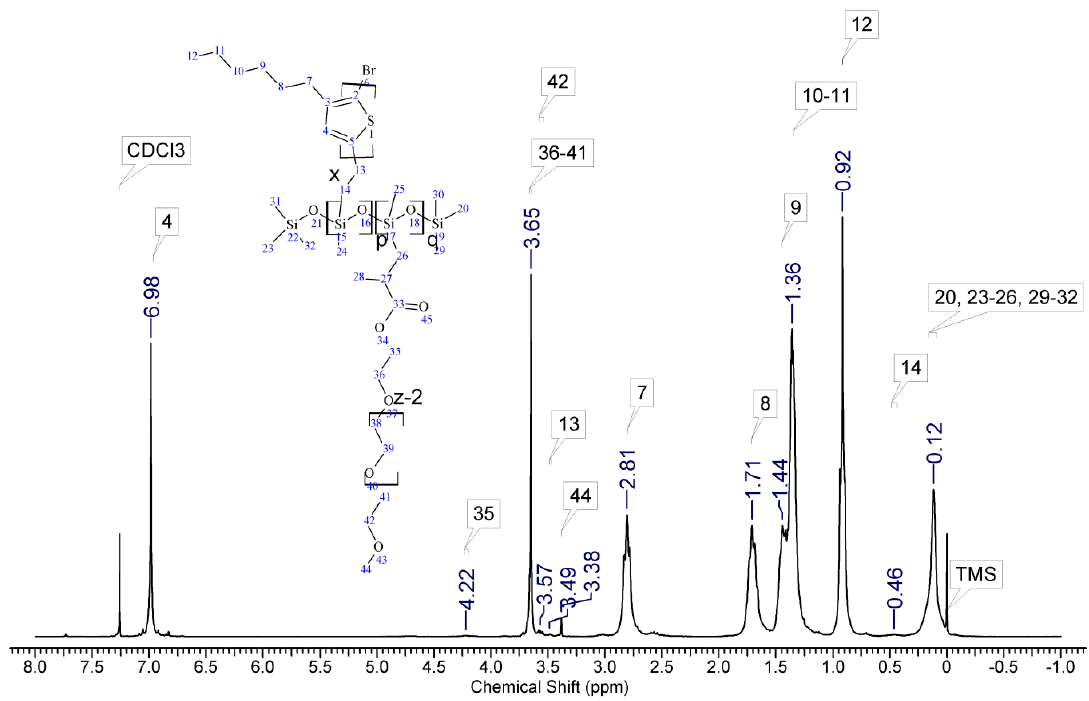
Figure A3. 1 H-NMR spectrum of poly(methylhydrosiloxane)-graft-[poly(3-hexylthiophene); poly(ethylene glycol) methyl ether methacrylate] (PEG M n ≈ 950) (SilPEG1.3).